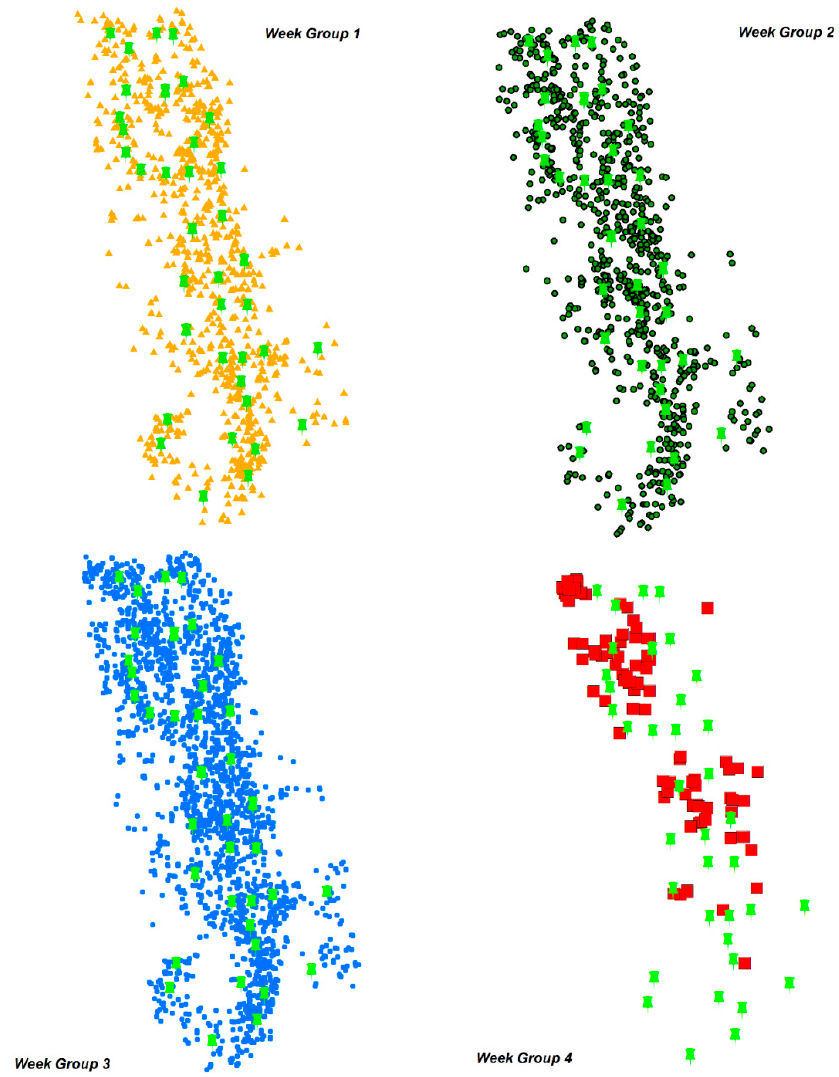
Figure 5. Sugar beet farm clusters based on Week groups.